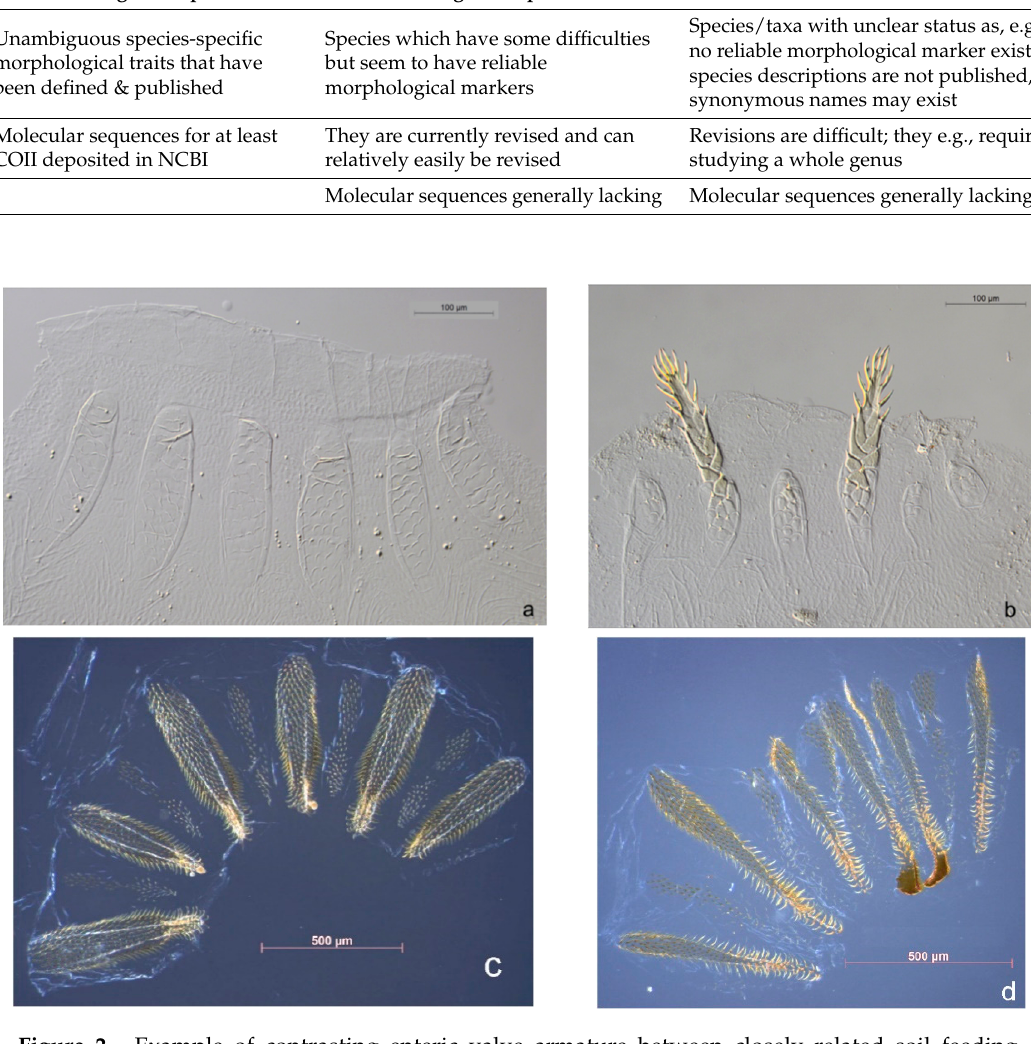
Figure 2. Example of contrasting enteric valve armature between closely related soil feeding termites. ( a , b ) Two species of soldier-less Apicotermitinae ( Astalotermes -group) from C ô te d’Ivoire. ( a ) Astalotermes quietus , ( b ) Anenteotermes polyscolus . Note the presence of six cushions in both species, all approximately equal and bearing crescent-shaped scales in Ast. quietus , but very dissimilar in An. polyscolus where two cushions bear long spiny extensions. Direction of flow is from bottom to top. ( c , d ): two Cubitermitinae from C ô te d’Ivoire. ( c ) Megagnathotermes notandus : six primary cushions of almost equal lengths, bearing a mesial ridge and, on both sides, regularly-spaced long spines (kind of combs), narrow secondary cushions; ( d ) Cubitermes proximatus : two primary cushions bearing a sclerotized spatula sticking out of the valve, narrow secondary